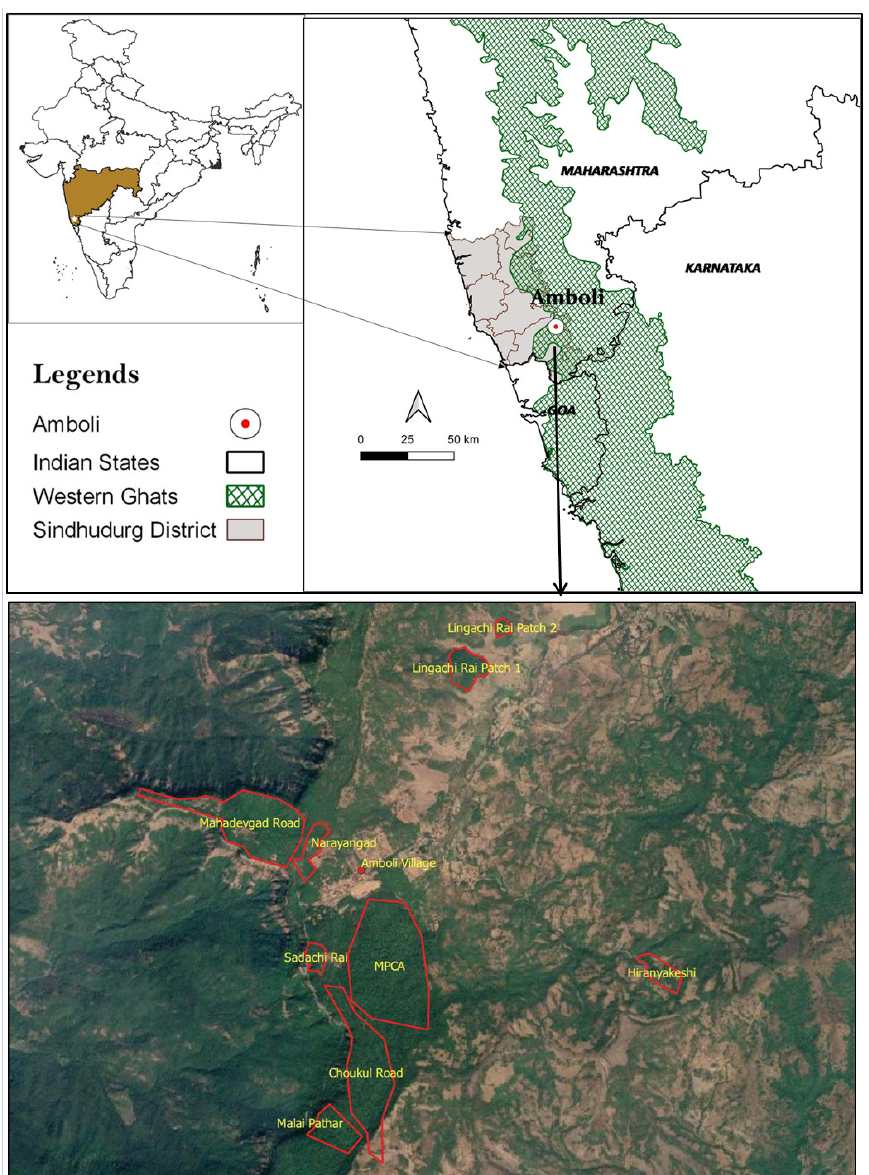
Figure 1. Study area. Source: QGIS Development Team